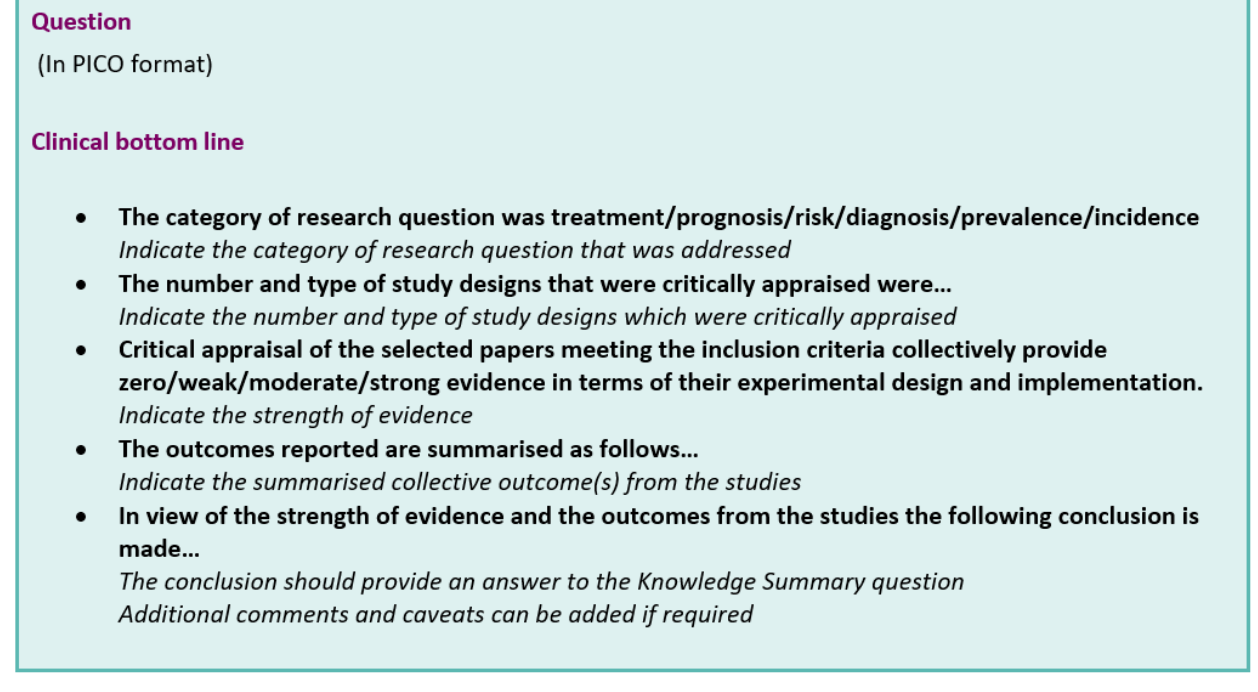
Figure 2: Example of completed clinical bottom